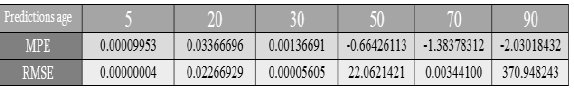
Table 2: The effects of life span on the accuracy of